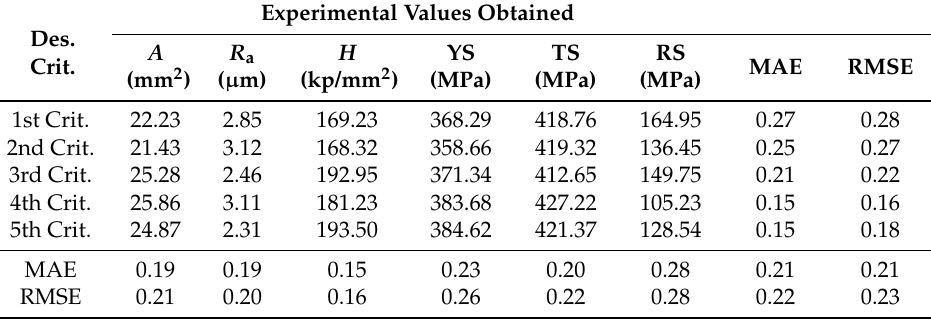
Table 15. Outputs or welded joint parameters that were obtained according to the five design requirements